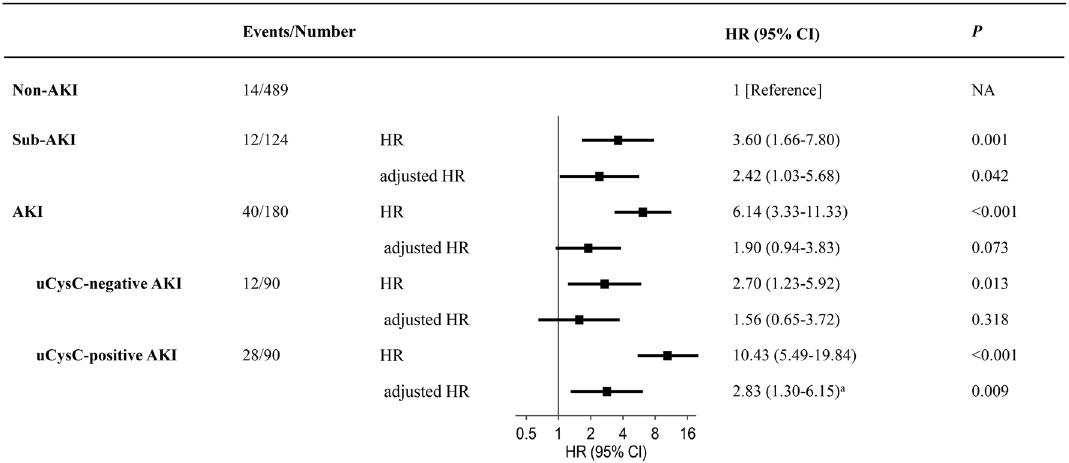
Fig. 4 Forest plot depicting the risk of 30-day PICU mortality. The non-AKI with the lowest risk of mortality was used as a reference. Adjusted HR: Model was adjusted for body weight, sex, illness severity assessed by the pediatric risk of mortality III score, multi-organ dysfunction syndrome, and mechanical ventilation. KI, acute kidney injury; CI, confidence interval; HR, hazard ratio; NA, not applicable; PICU, pediatric intensive care unit; sub-AKI, subclinical AKI; uCr, urinary creatinine; uCysC, urinary cystatin C